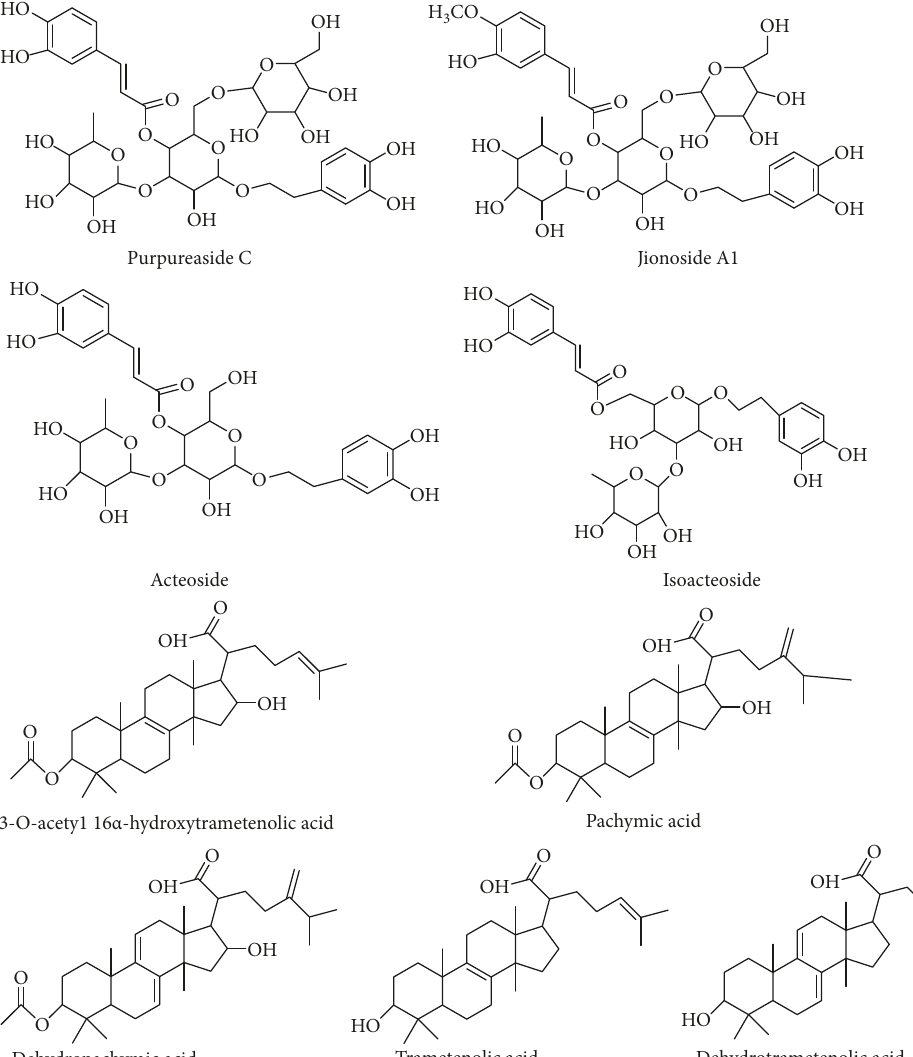
Figure 1: Structure of four phenylethanoid glycosides and five triterpene